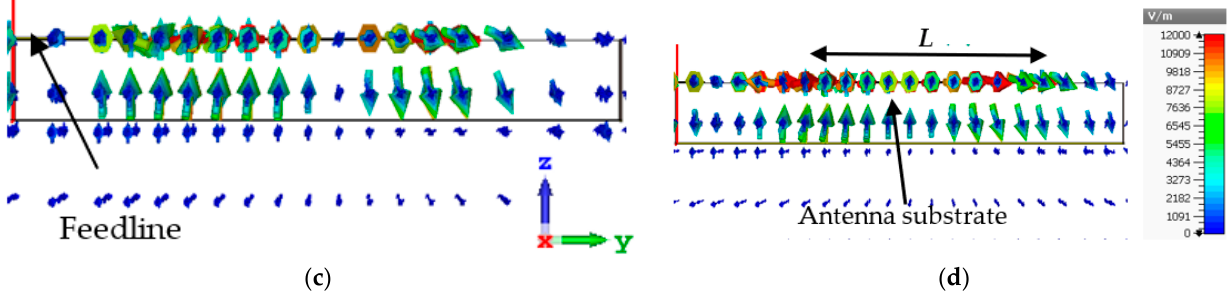
Figure 8. E-field distribution for ( a ) Antenna 1, ( b ) Antenna 2, ( c ) 3D view (without parasitic element) and ( d ) 3D view (with parasitic element).